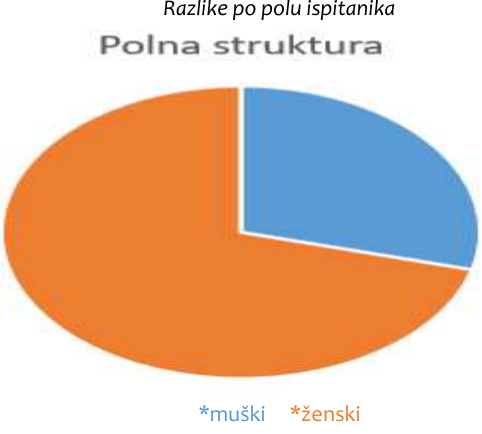
obe skale. U slučaju skale HV, t (149) = -4.15. p < 0.001, i u slučaju skale SV, t (149) = -3.06. p